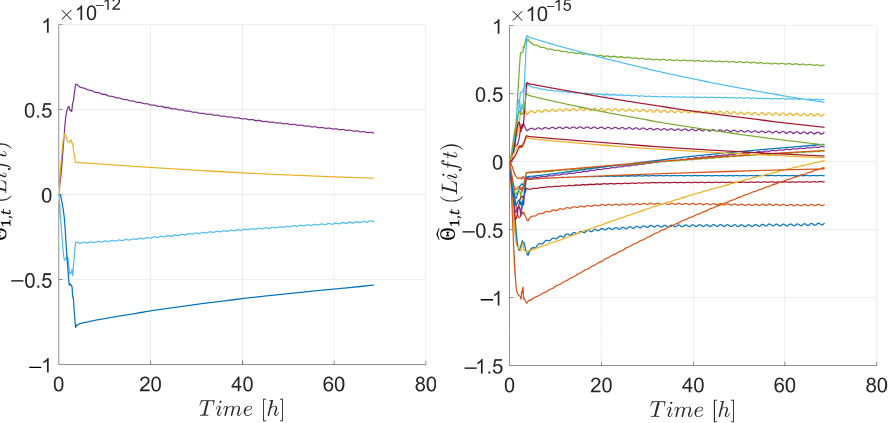
Figure 12. Parameter estimates from the attitude controller associated with the aerodynamic lift of the target. Components (cid:98) B 1 (cid:98) C L , j of (cid:98) Θ 1 , t with j = 1,2,3,4 ( left ), remaining components of (cid:98) Θ 1 , t ( right